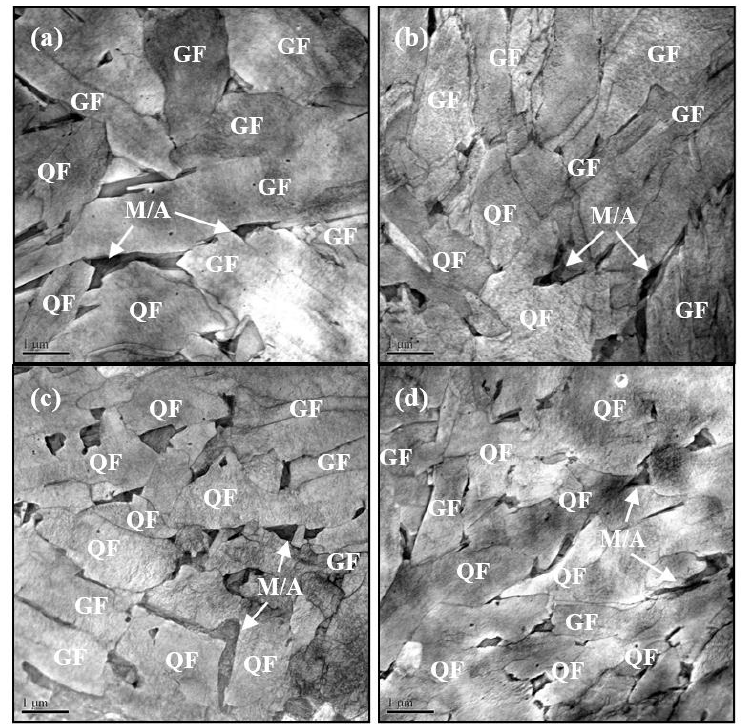
Figure 7. The TEM images of the typical microstructure morphology in the specimens with different finish rolling temperatures: ( a ) 850 °C; ( b ) 830 °C; ( c ) 810 °C and ( d ) 790 °C. finish rolling temperatures: ( a ) 850 ◦ C; ( b ) 830 ◦ C; ( c ) 810 ◦ C and ( d ) 790 ◦ C.